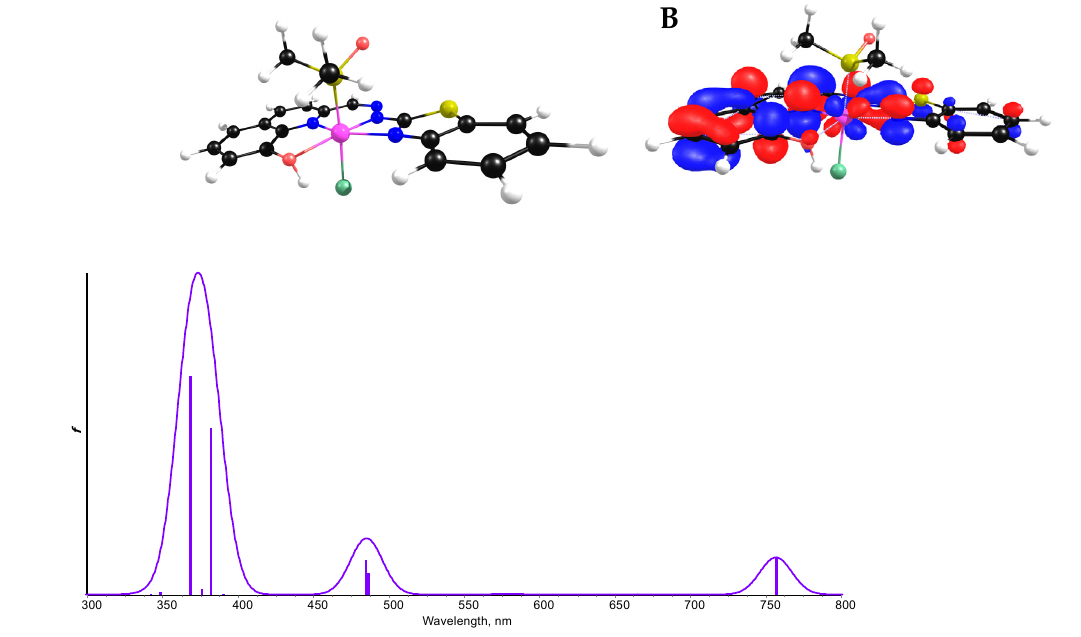
Figure 5. ( A ) DFT structure or the Ru complex, ( B ) LUMO orbital of the Ru complex and ( C ) corresponding absorption spectra.